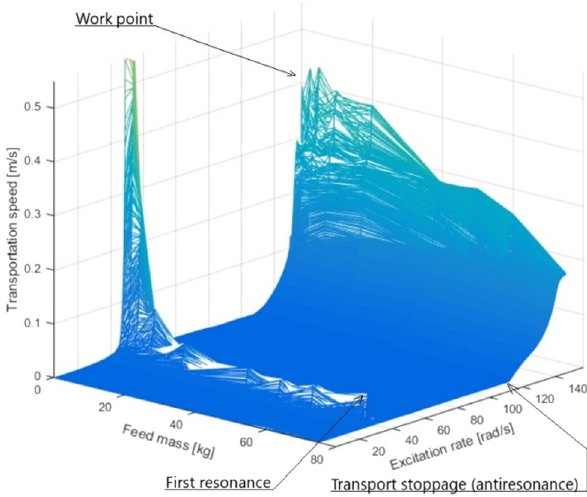
Figure 6: Transport velocity as a function of the excitation frequency in dependence of the feed mass for quasi steady states.